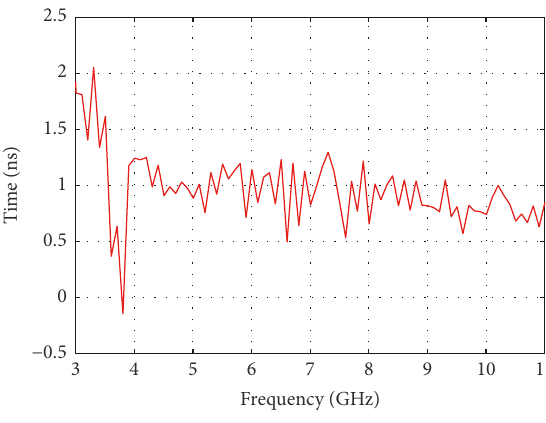
Figure 11: Measured group delay.